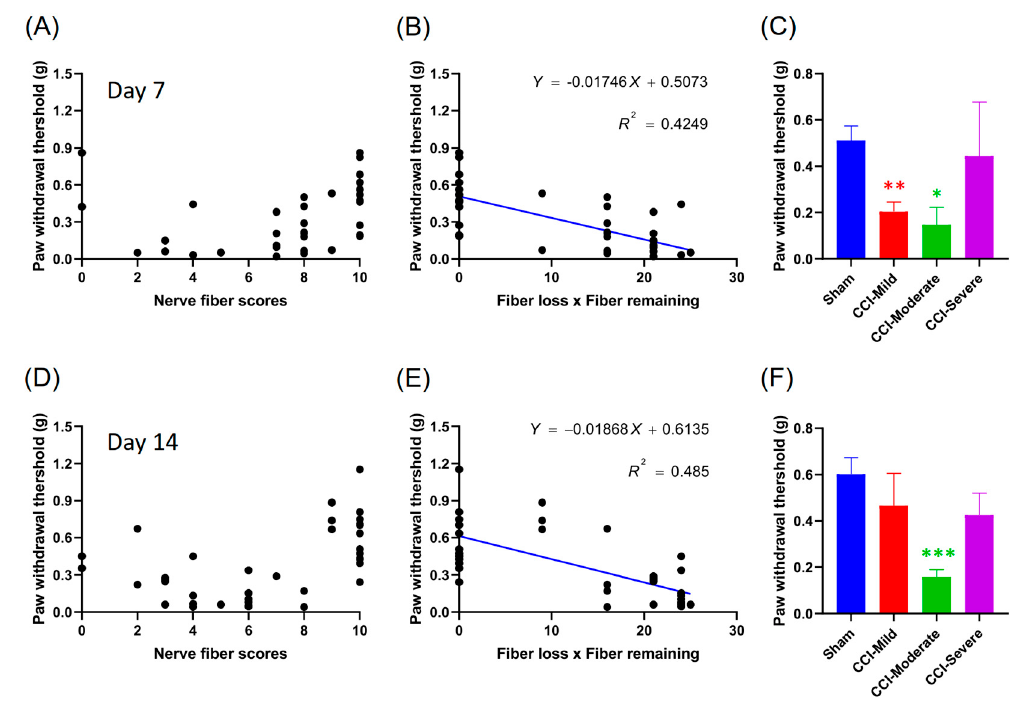
Figure 5. Correlation between mechanical threshold and the product of nerve scores. ( A ) Scatter plots showing data from individual mice data at 7 d after CCI surgery. ( B ) Mechanical hypersensitivity was correlated significantly with the product of the nerve score (surviving fibers) and the number of fibers lost (10 − nerve score) at 7 d ( p < 0.001). ( C ) The CCI-injured mice were divided into three subgroups according nerve score. Both the CCI-mild and the CCI-moderate groups showed mechanical hypersensitivity at 7 d. Panels ( D – F ) show data recorded at 14 d. Notably, only the CCI-moderate group exhibited mechanical hypersensitivity at 14 d, while the CCI-mild group had recovered and was not significantly di ff erent from the sham group. * p < 0.05, ** p < 0.01 and *** p < 0.001, compared with the sham group.